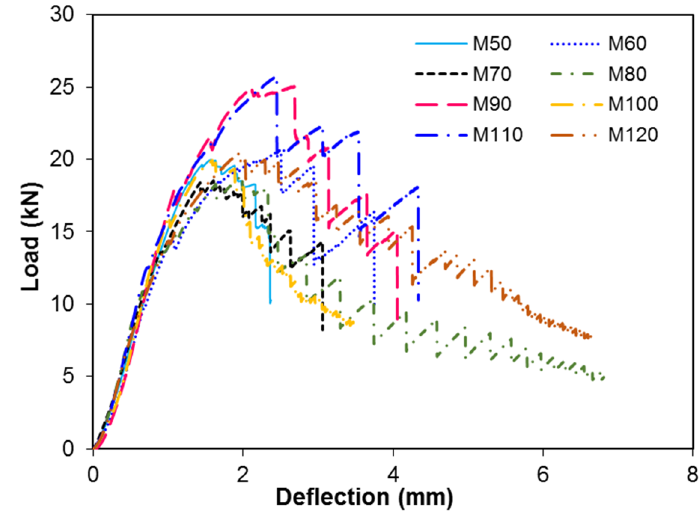
Figure 12. Load vs. deflection for different concrete mixtures.